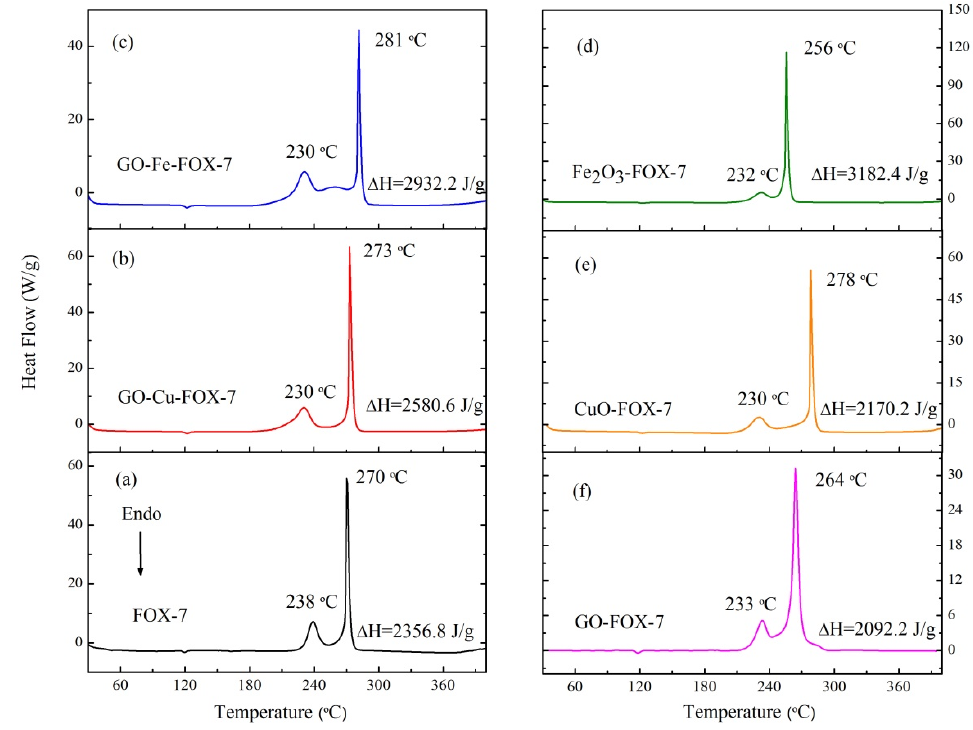
Figure 6. DSC curves of ( a ) FOX-7, ( b ) nGO-Cu-FOX-7, ( c ) nGO-Fe-FOX-7, ( d ) Fe 2 O 3 -FOX-7, ( e ) CuO-FOX-7 and ( f ) nGO-FOX-7 with heating rate of 10 °C/min.